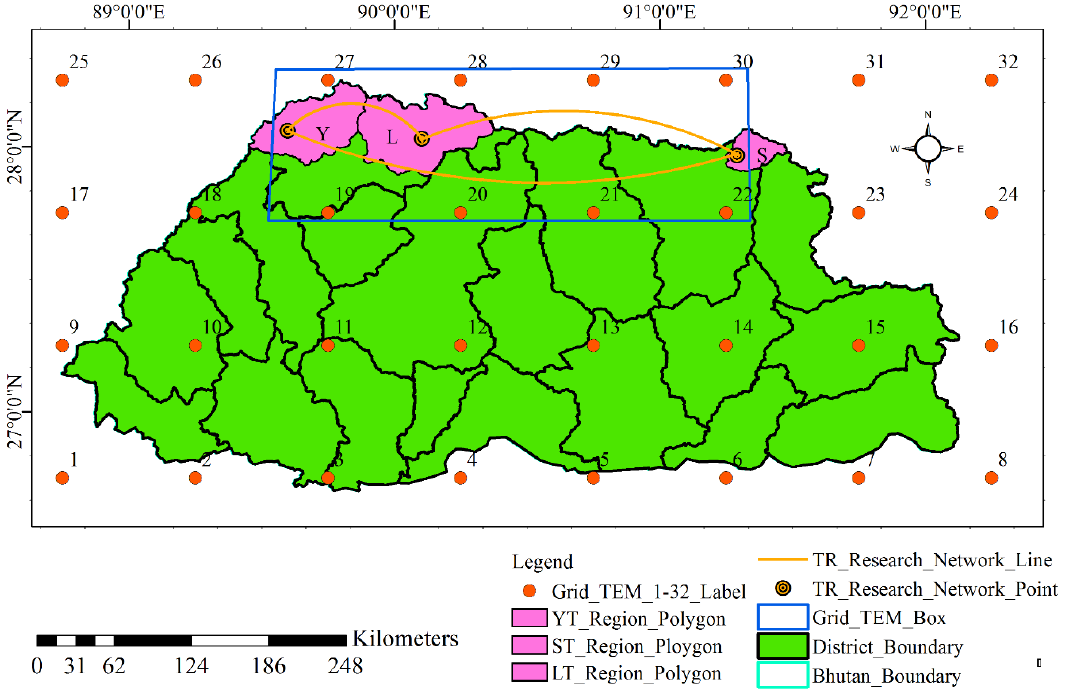
Figure 3. Tree-ring treeline network research sites and 32 gridded CRU temperature data stations over Bhutan. A map shows three specific treeline sites (golden concentric circles) and three treeline regions (L — Lunana, Y — Laya, and S — Singye Dzong — pink polygons) connected by golden thick curved lines inside blue box. Gridded temperature stations dotted by red colour. Six gridded CRU –19, 27, 20, 28, 21, and 29 (inside blue box) were used as representative temperature variables (NBGridTEM-6).